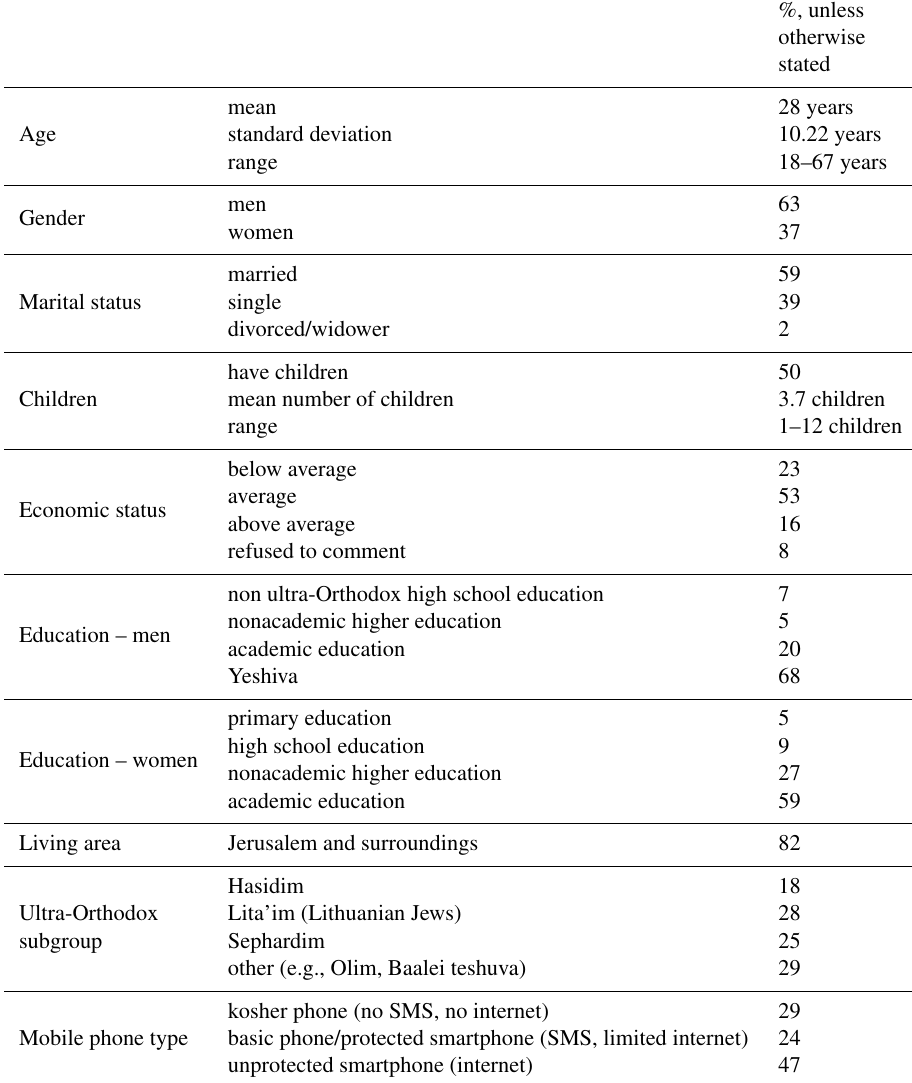
Table 2. Demographic features of the